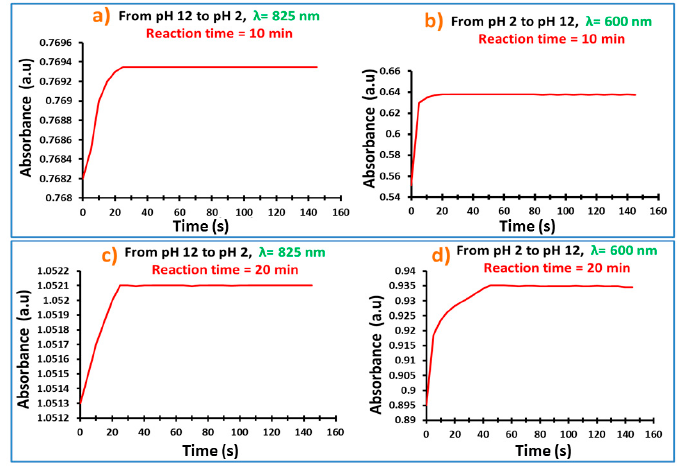
Figure 6. Response time for PANI-PSU-10 membranes ( a , b ) and PANI-PSU-20 membranes ( c , d ). Each membrane was placed in a buffer solution of pH 12 and then in buffer solution of pH 2 for the measurement of response time at 825 nm; after that, the same membrane was placed back in a buffer solution of pH 12 for the measurement of response time at 600 nm.